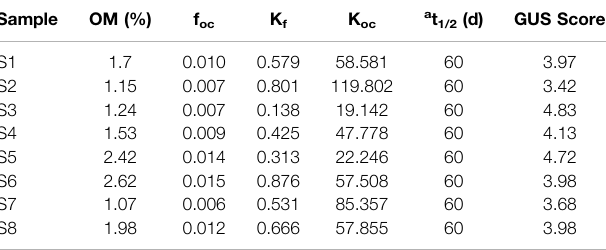
TABLE 5 | GUS scores of each soil sample collected in agricultural areas.